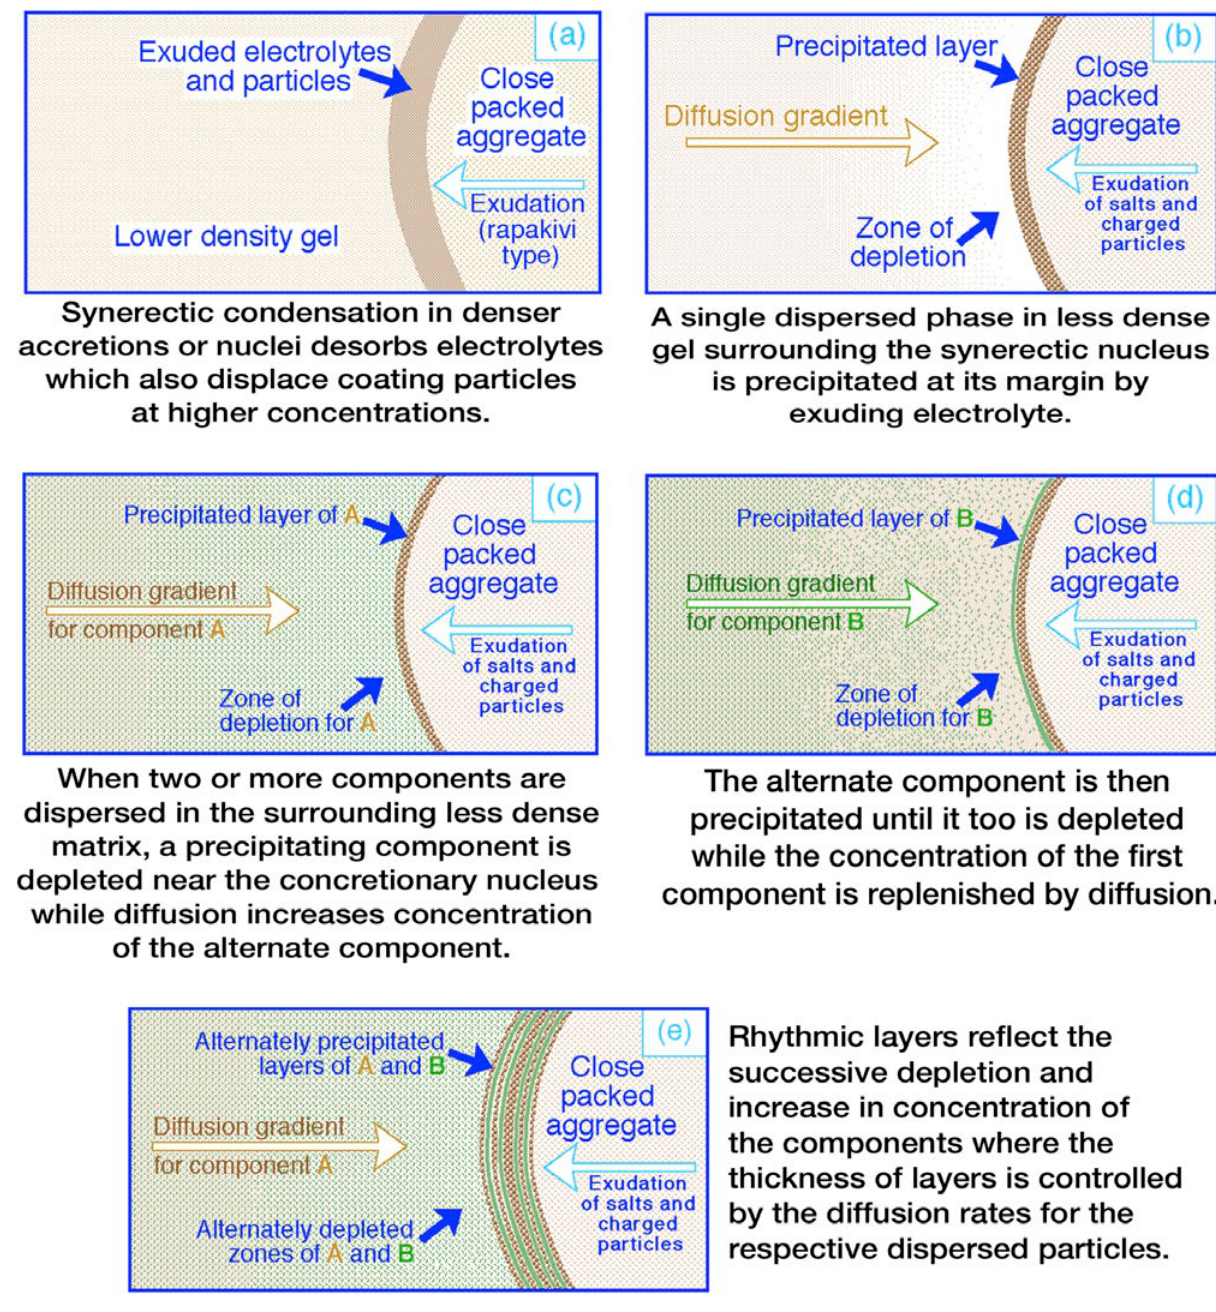
Figure 68. A schematic diagram indicates the exudation from synerectic nuclei of desorbed electrolyte and ‘surface coating’ charged parti- cles which precipitate concretionary overgrowths or rimming bands. The principal stages in the saturation - precipitation - depletion - diffu- sion and re-saturation cycle that gives rise to rhythmic layering are indicated. Essentially the mechanism by which the diffusing particles are precipitated at the surface of the growing nucleus, is by coagulation. They encounter an increase in the concentration of electrolyte diffus- ing outward from the nucleus. This reduces the thickness of the Helmholtz double layer so that they can 'plate out' on the